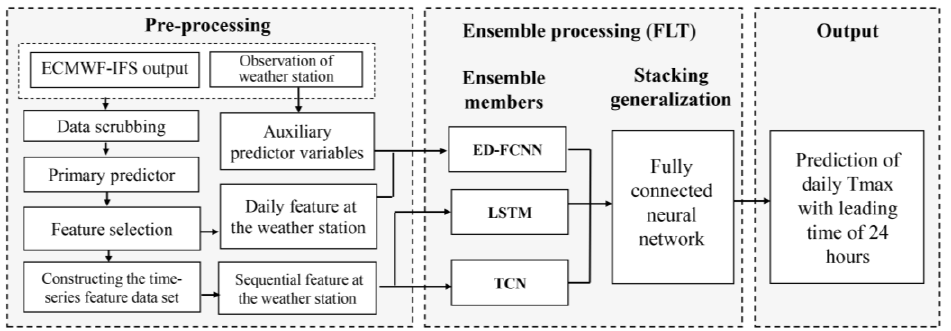
Figure 3. Flow chart of the proposed FLT base on three neural network models by stacking generalization technique.